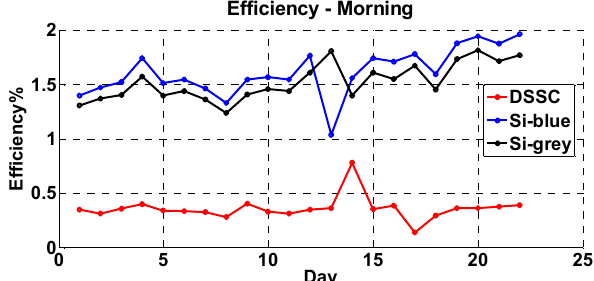
Figure 25. Efficiency profiles in the morning of the three generation systems. From the trends it is possible to remark that the Si-blue has better performances respect Si-grey, only for a particular event this trend is not verified.